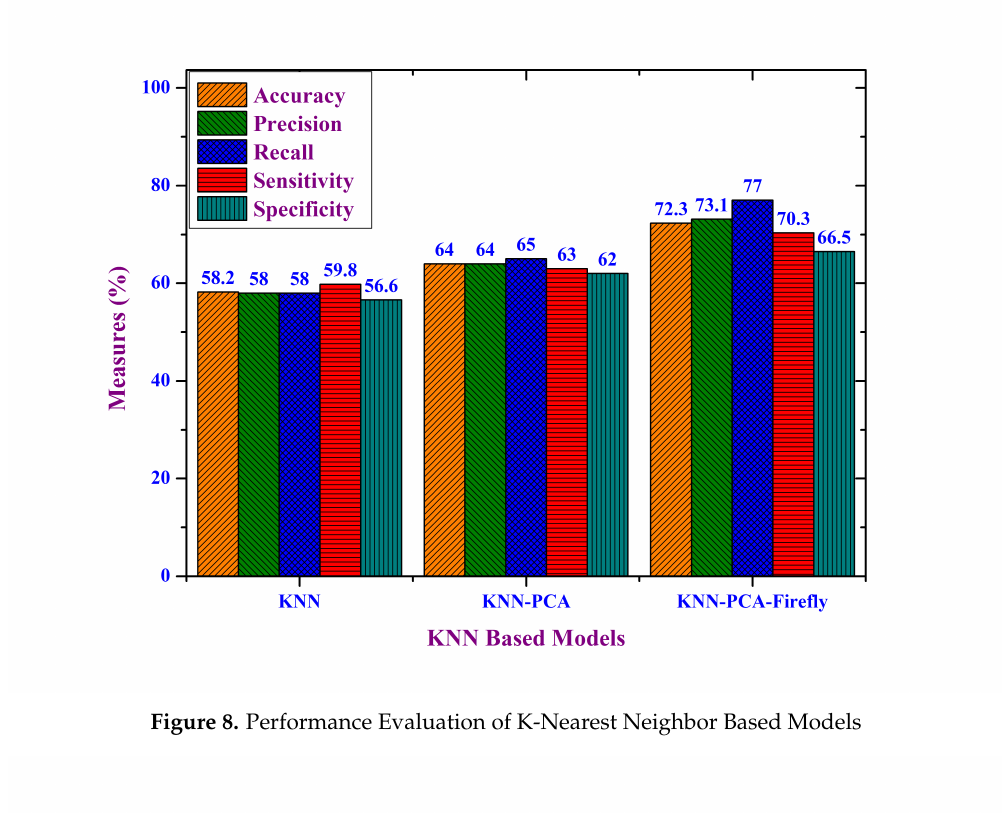
Figure 8. Performance Evaluation of K-Nearest Neighbor Based Models